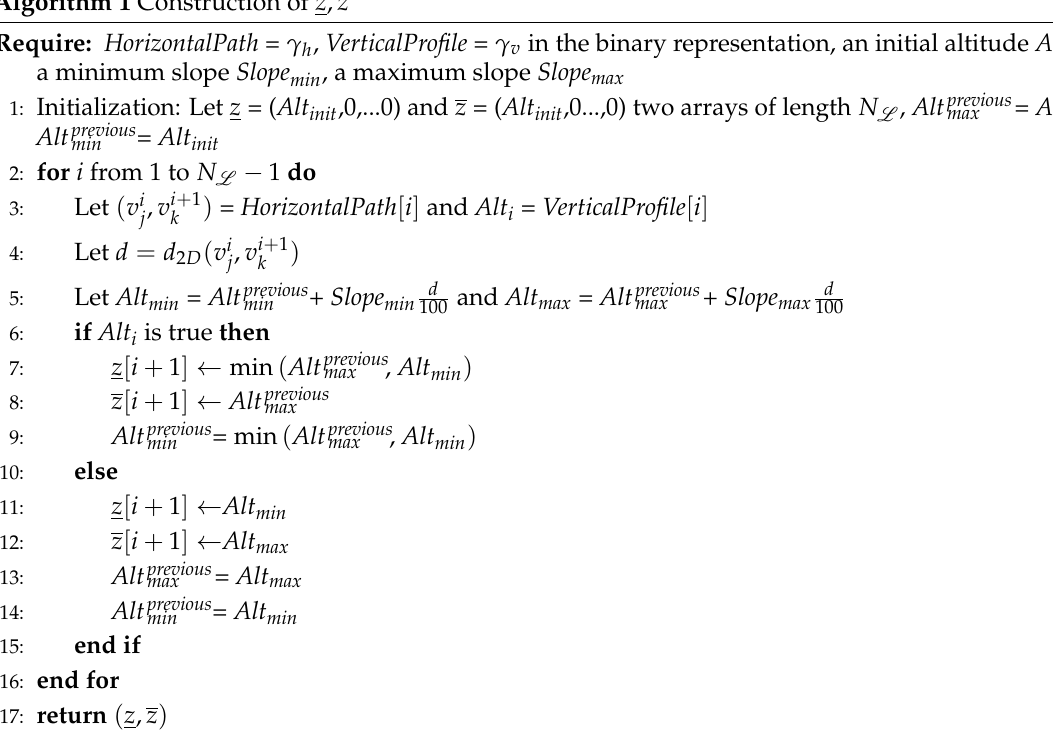
Algorithm 1 Construction of z ,